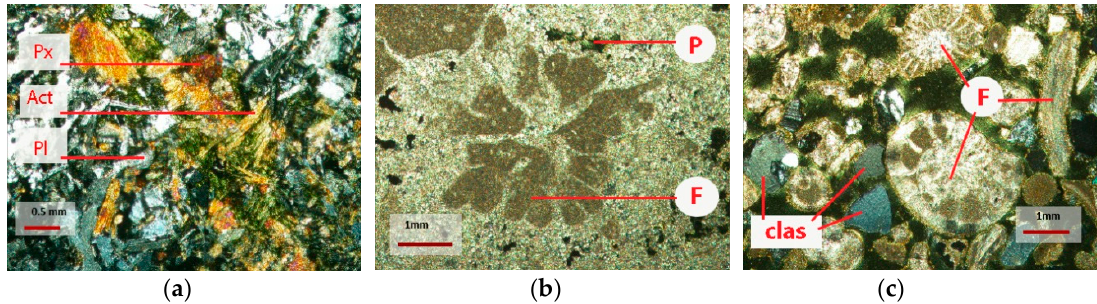
Figure 2. Photomicrographs (crossed Nicols) of representative samples from the aggregates under investigation: ( a ) Diabase/Basalt—pyroxene altering to actinolite (Px: Pyroxene, Act: Actinolite, Pl: Plagioclase); ( b ) Reef Limestone—remnants of fossils; considerable percentage of pore space and voids (P: Pores, F: Fossil (coral)); ( c ) Calcarenite Limestone—grains mostly of limestone, fossils,